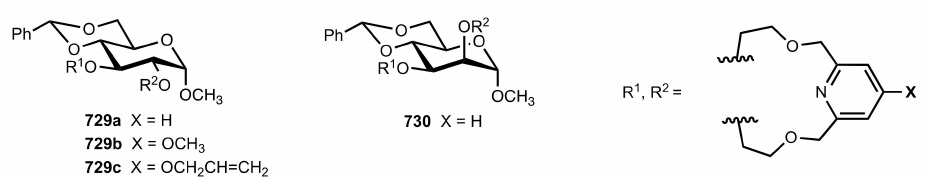
Figure 48. Aza-crown ether containing a pyridine ring prepared by Bak ó and